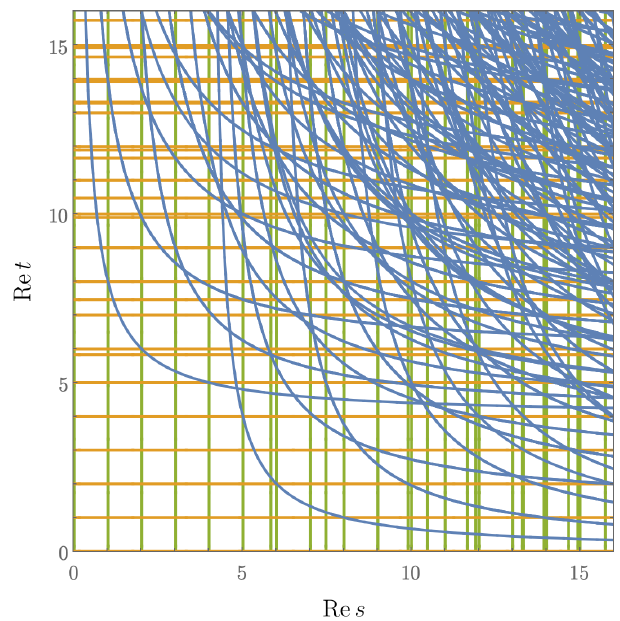
Figure 24: All Landau singularities of the planar amplitude in the region 0 ⩽ s , t < 16: normal thresholds in the s - and t -channel (green and orange), as well as box anoma- lous thresholds